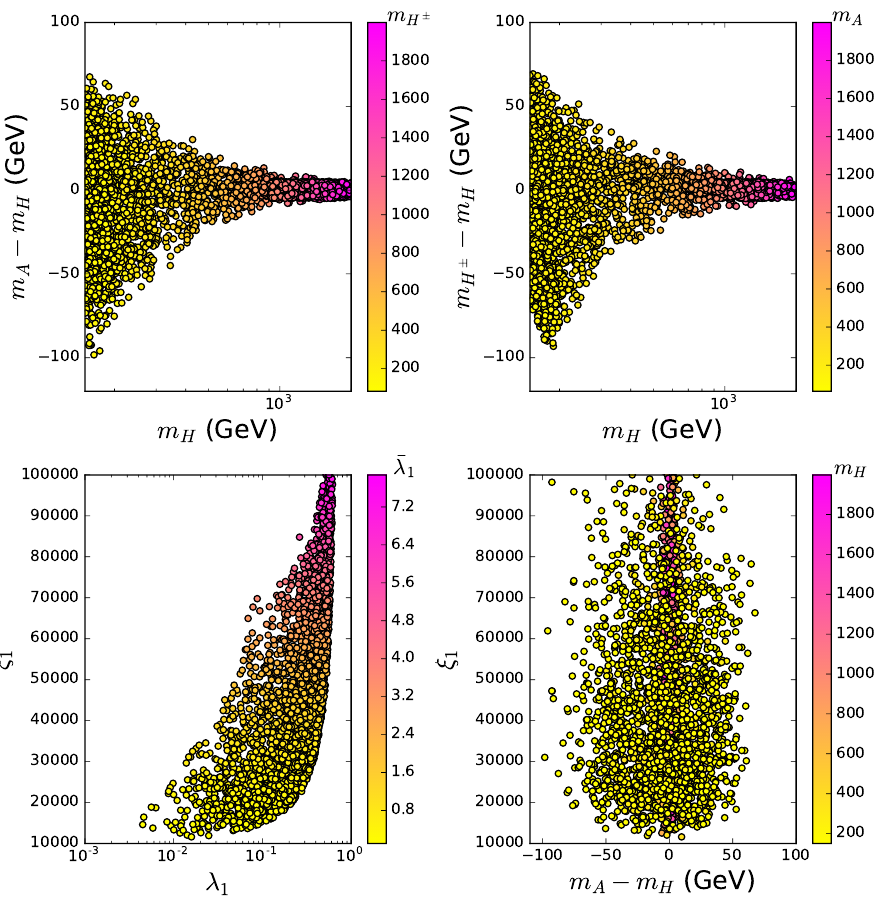
Figure 5 . In the type-I model, all the surviving samples satisfies the constraints of pre-inflation, h 1 -inflation, the exclusion limits from searches for Higgs at LEP, the flavor observables, R b , and the direct searches at the